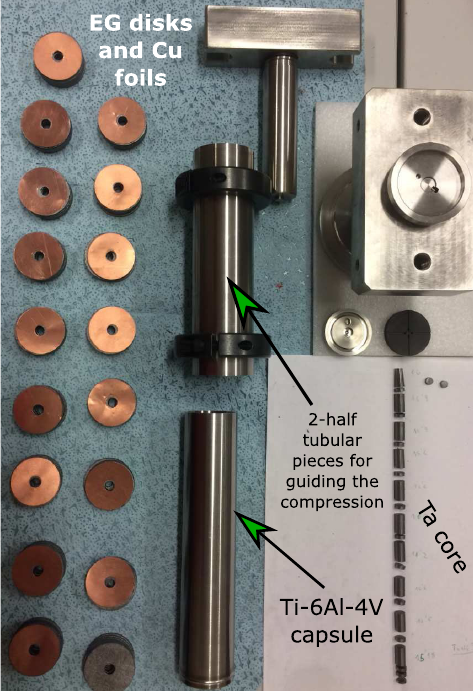
FIG. 3. Picture of the different parts of the HRMT-42 target and auxiliary pieces before assembly.